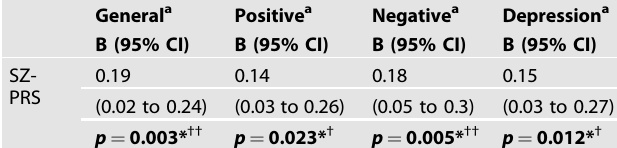
B Unstandardised regression coef fi cient, CI con fi dence interval. Covariates in multiple models were sex, age, and ten ancestry PCs. Associations nominally signi fi cant after permutation analysis are shown in